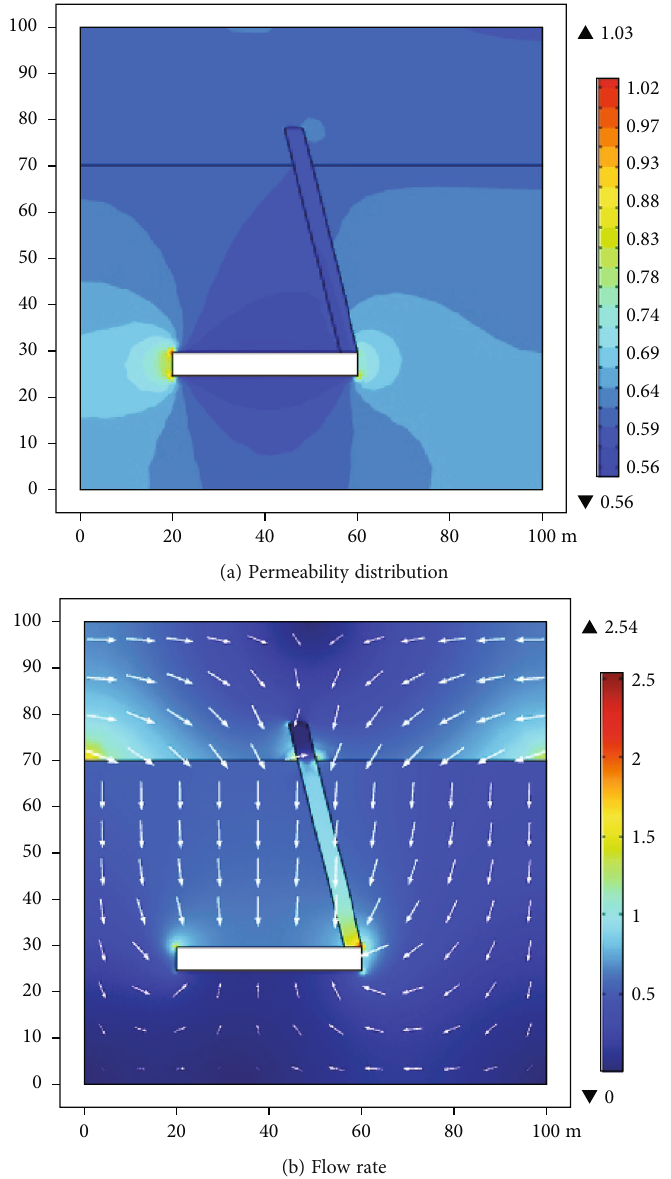
Figure 8: Permeability distribution and fl ow rate of seepage fi eld when L =